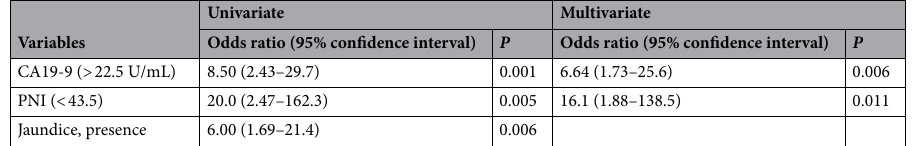
Table 5. Preoperative predictors for the presence of lymph node metastases. CA carbohydrate antigen, PNI prognostic nutritional